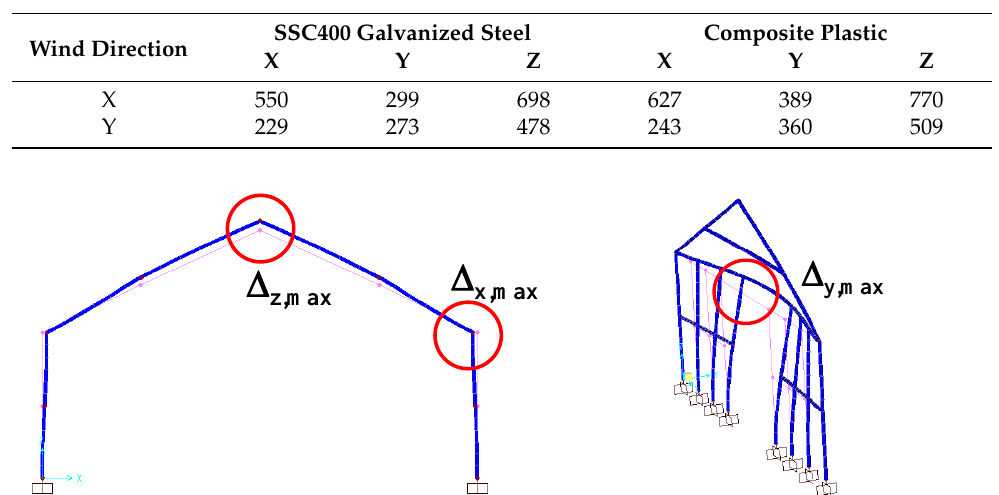
Table 4. Comparison of peak displacement response (mm).